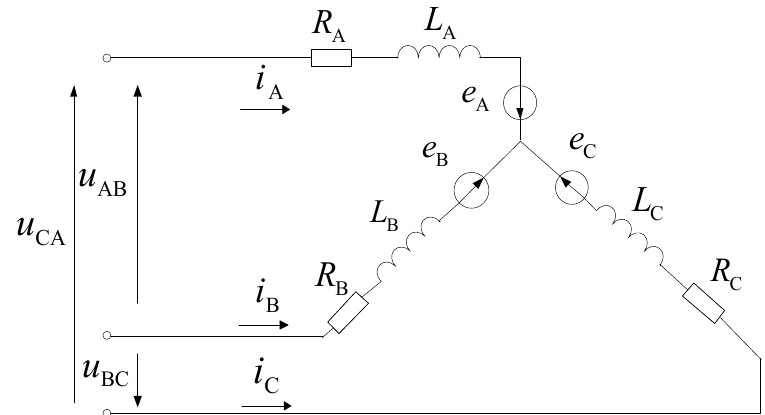
Figure 2. Equivalent circuit diagram of stator winding.